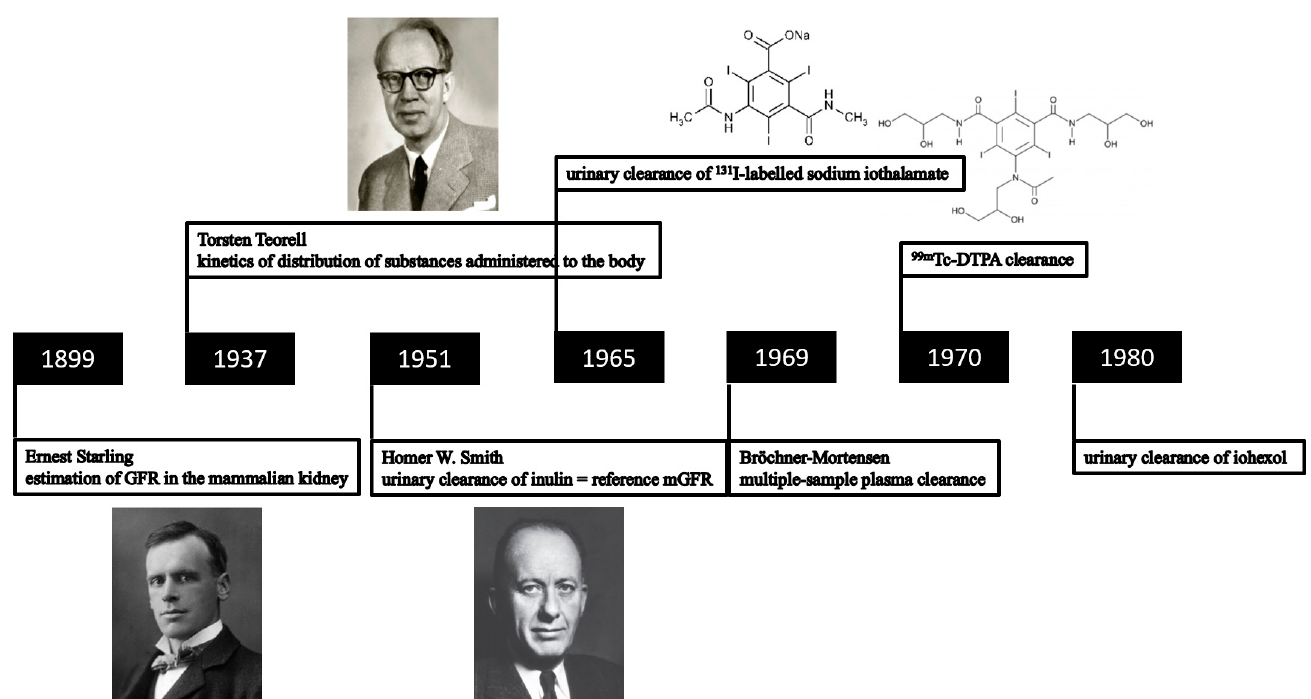
Figure 2. Timeline representing the evolution of the use of exogenous filtration markers for the determination of GFR.